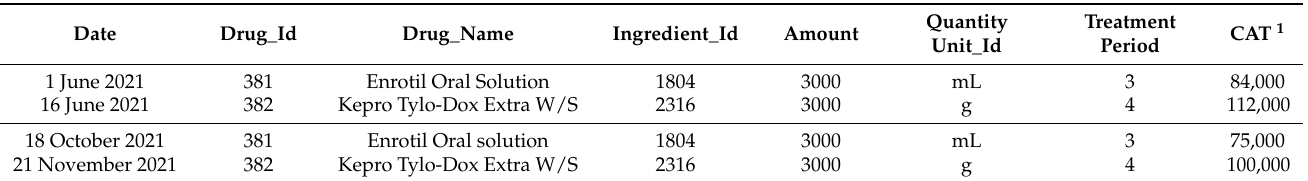
Table 1. Brief output for farm_id 84, therapy ID: 87, 89, (broiler, population of 28,000 chickens)